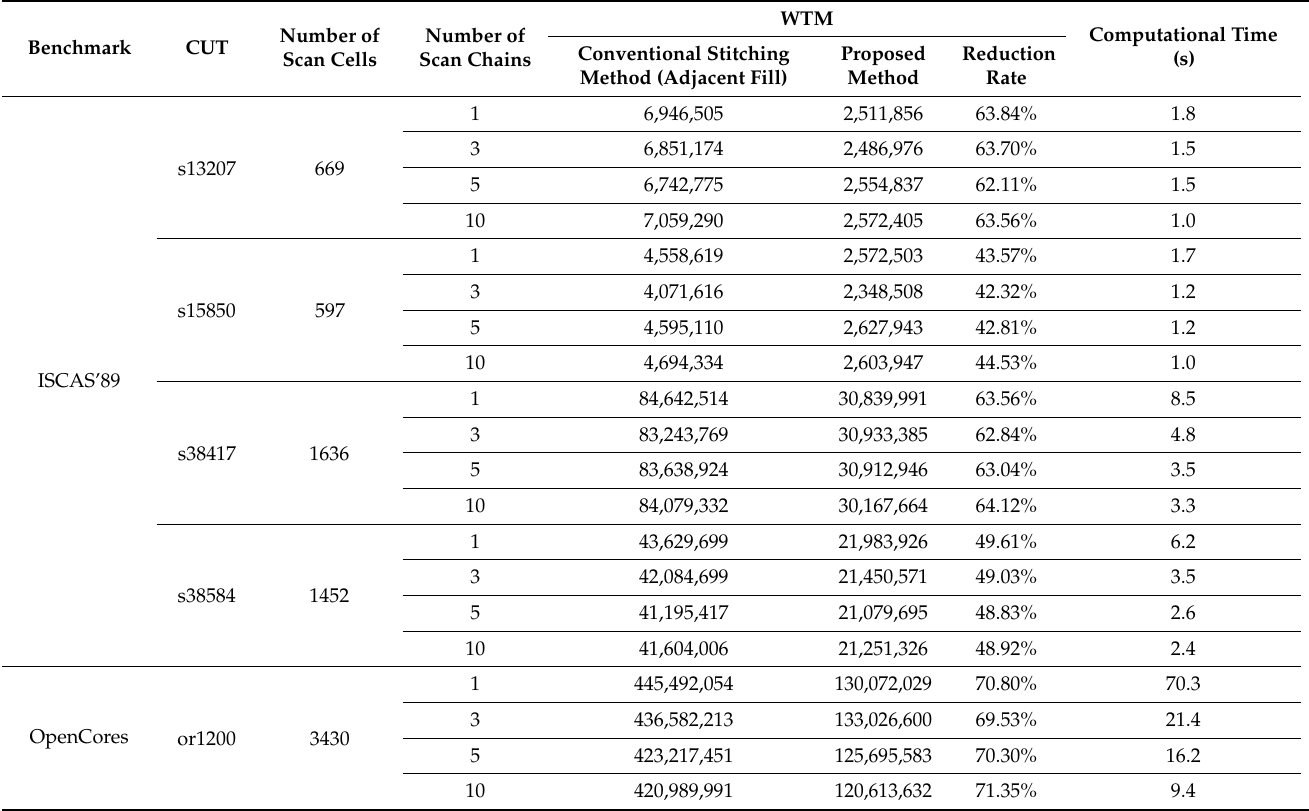
Table 5. Comparison of computational time with the previous